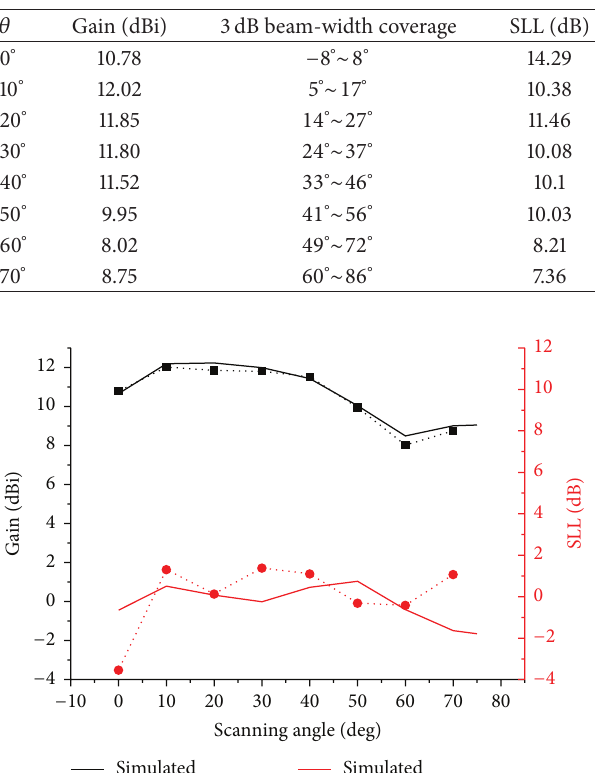
Table 4: Measured scanning characteristics of the prototype.